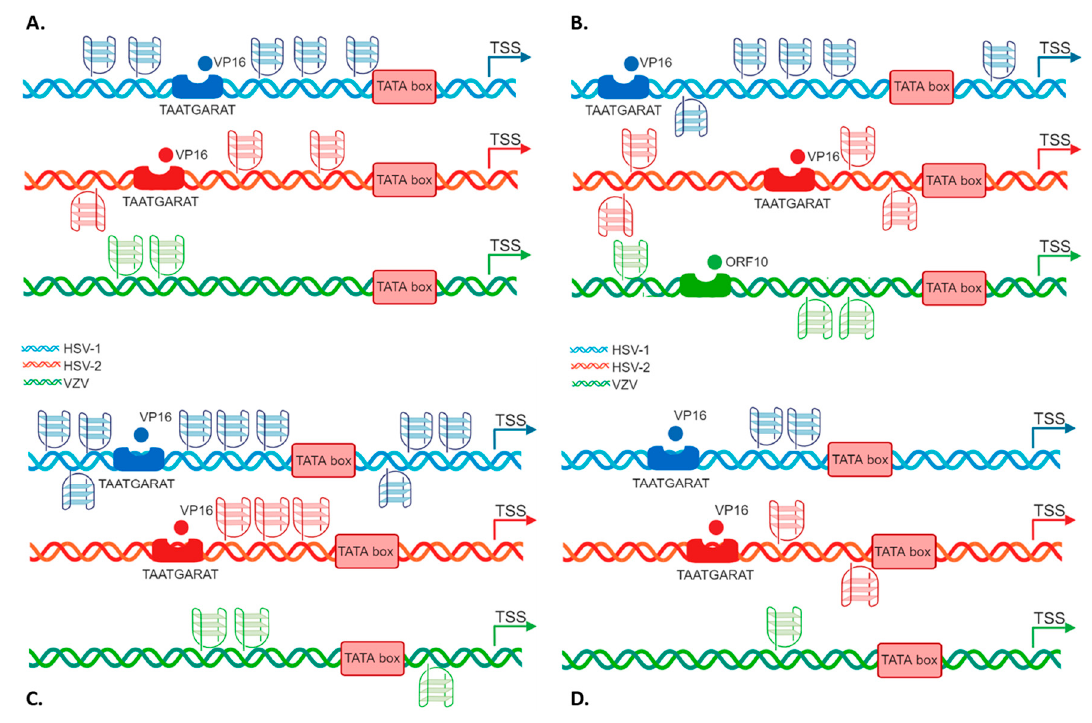
Figure 1. Schematic comparative representation of G4s in Alphaherpesvirus IE promoters. The four IE promoters ( A . ICP0 ; B . ICP4 or ORF62 ; C . ICP22/ICP47 or ORF63 and D . ICP27 ) are reported. HSV-1, HSV-2 and VZV promoter schemes are shown in blue, red and green, respectively. The TAATGARAT region is shown as a blue/red box with the VP16 protein nearby (or as a green box with ORF10 protein in the case of VZV); the TATA box is represented as a red box; the arrow indicates the position of the Transcriptional Start Site (TSS). The position of each of these features on the double helix with respect to the TSS is on scale. In each promoter, the predicted G4s are shown above and below the DNA strand for G4s present in the leading and lagging strand, respectively.